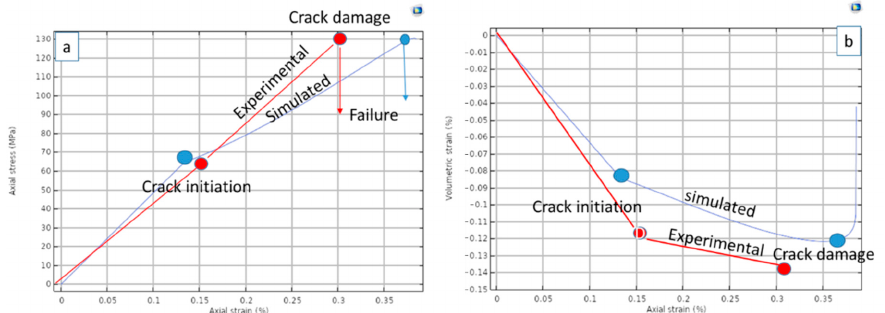
Figure 6. Stress-strain-volume deformation of LdB granite in uniaxial compression test: ( a ) Axial stress vs. axial strain; ( b ) Volumetric strain vs. axial strain.